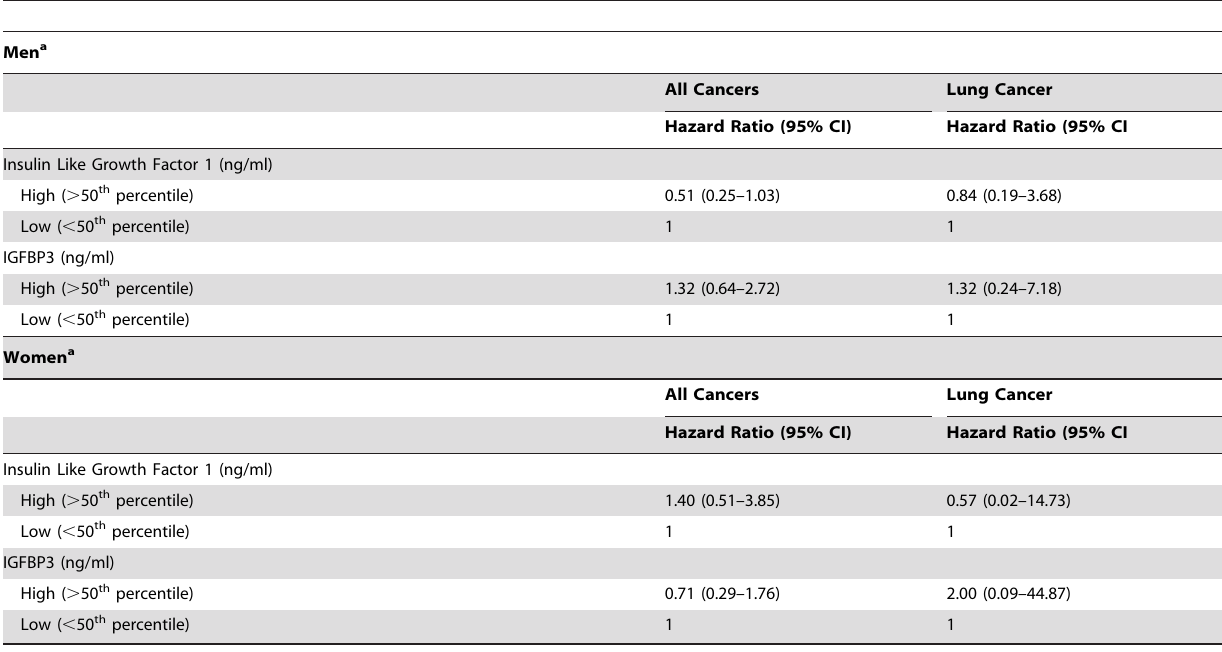
Table 3. Cancer mortality analysis of risk factors associated with all-cause and lung cancer mortality with integration of insulin like growth factor 1 and IGF binding protein 3